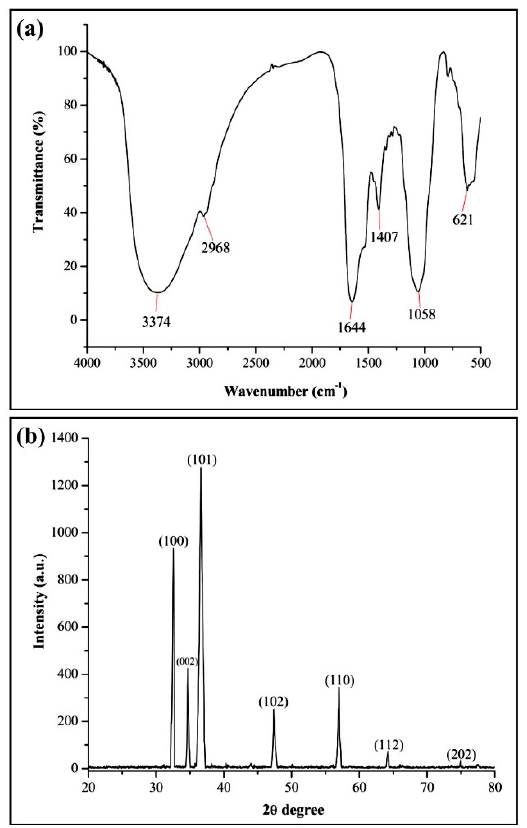
Figure 3. Characterization of biogenic ZnONPs synthesized from B. cereus RNT6. ( a ) FTIR spectra, ( b ) XRD analysis.